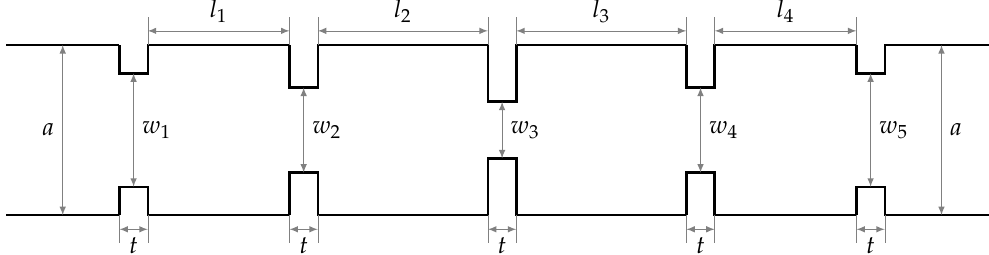
Figure 1. Layout of an all-metallic coupled cavities filter in rectangular waveguide. The filter has been design for different number of resonant cavities R . In all cases, the width of the guide is a = 15.7988 mm, the height is b = 7.8994 mm, and the length of the inductive irises is t = 2 mm. Below, the remaining dimensions for different filter order R are